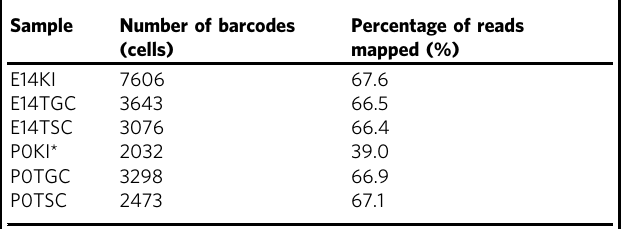
Table 1 Number of barcodes and percentage of reads mapped for each 10x scRNA-Seq